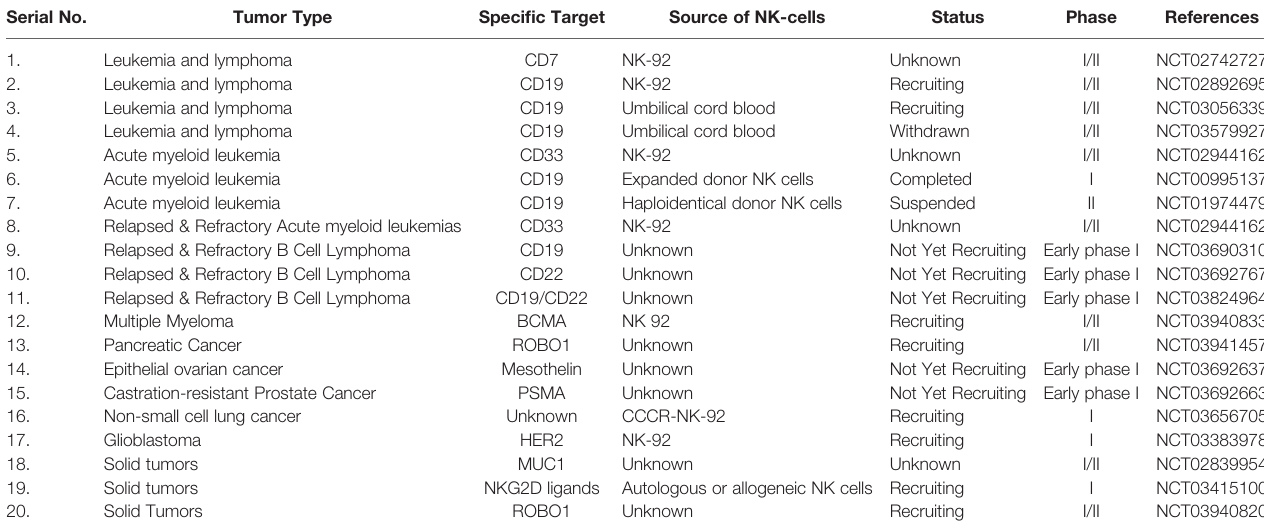
TABLE 1 | Clinical trials of CAR-NK cell therapies against hematological malignancies and solid tumors. Serial